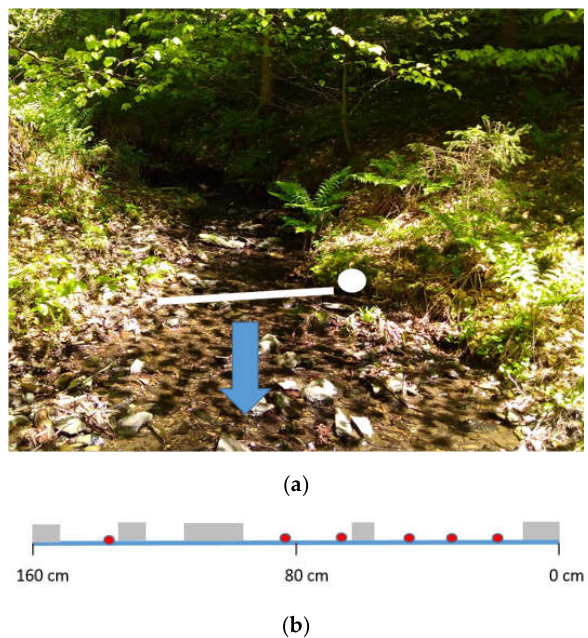
Figure 7. ( a ). Photograph of the measured channel section for the Weierbach. Arrow pointing downstream (picture J. Klaus); ( b ). Cross-section schematic of the Weierbach channel showing positions of exposed rocks and chloride sensors.